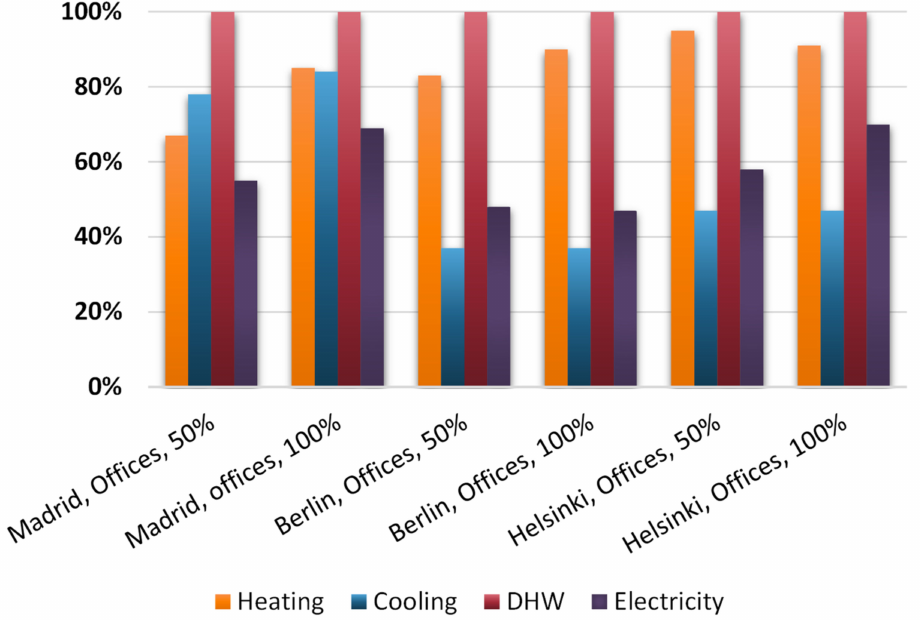
Figure 12. Share of renewables for the examined